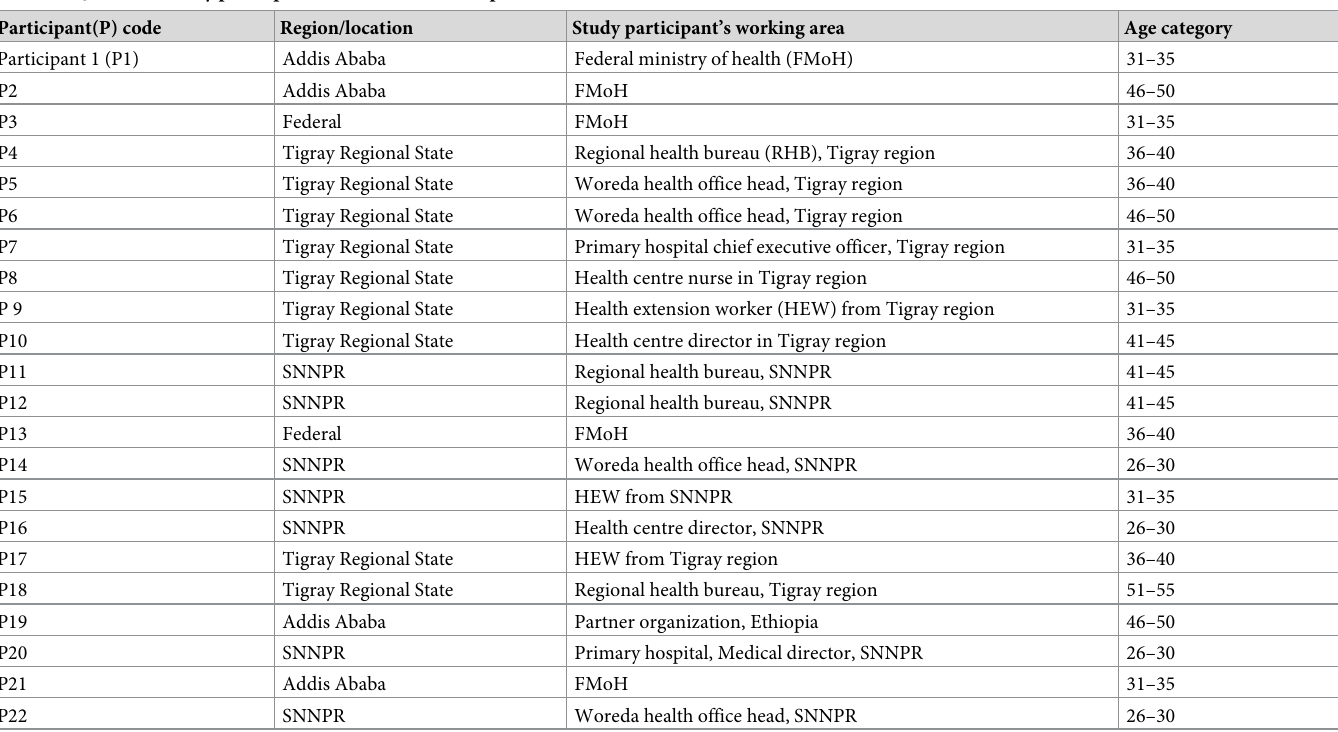
Table 1. Qualitative study participant characteristics, Ethiopia,